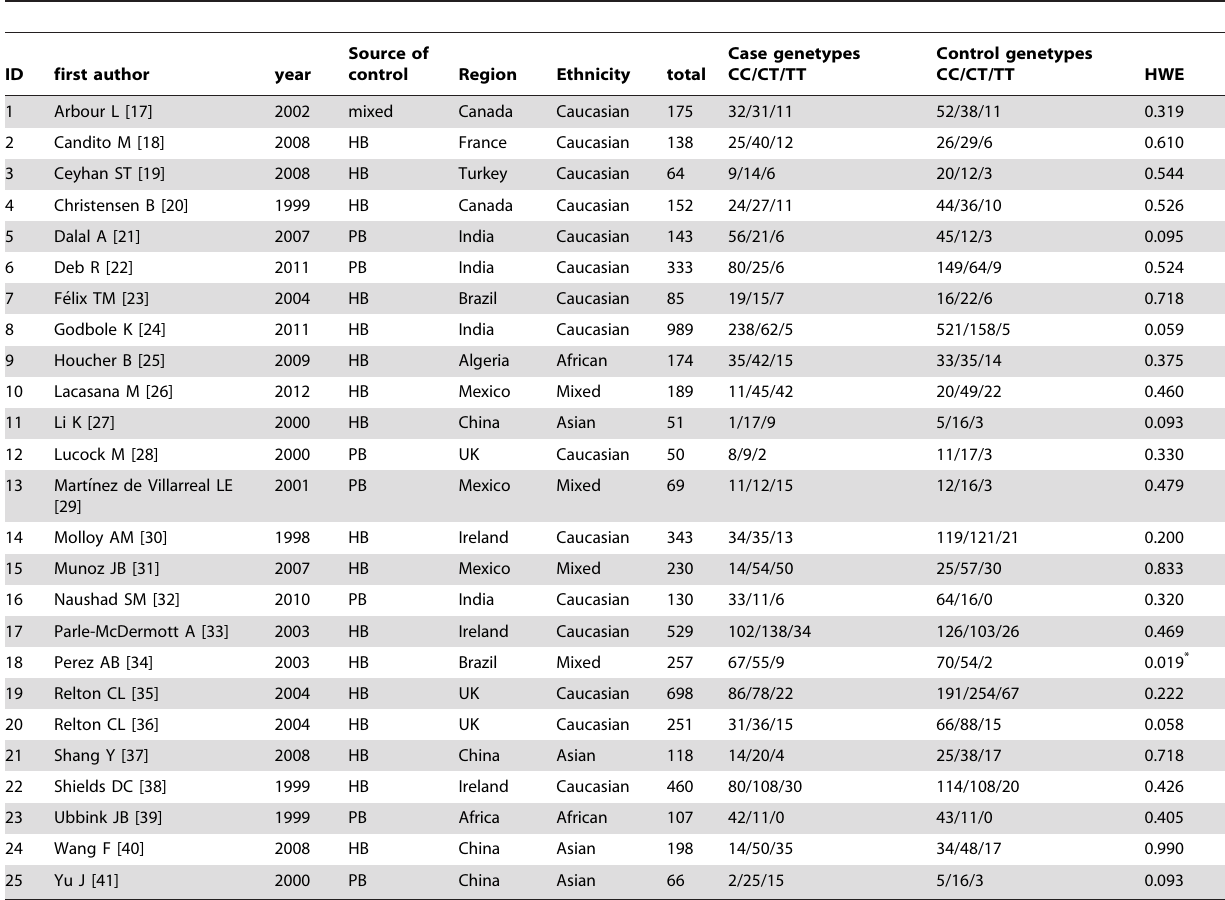
Table 1. Characteristics of the association studies on maternal MTHFRC677T polymorphism and the risk of Neural tube defects